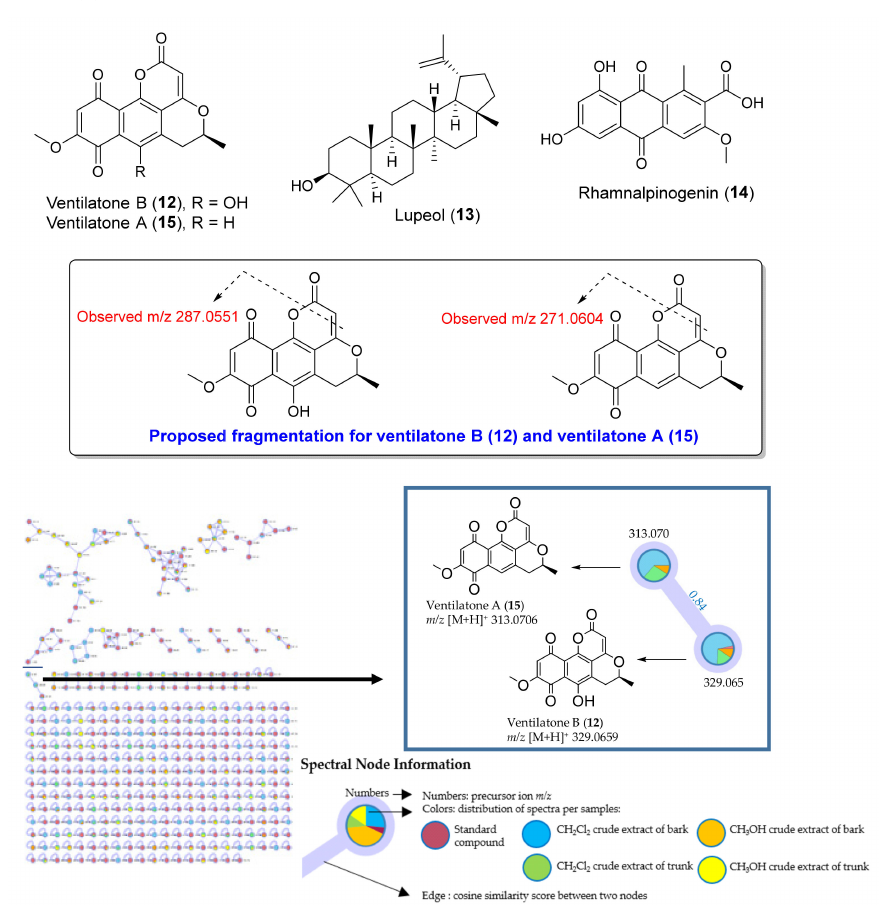
Figure 5. Structures of ventilatone B ( 12 ), lupeol ( 13 ), rhamnalpinogenin ( 14 ) and ventilatone A ( 15 ); proposed fragmentations and molecular networking of ventilatone B ( 12 ) and ventilatone A ( 15